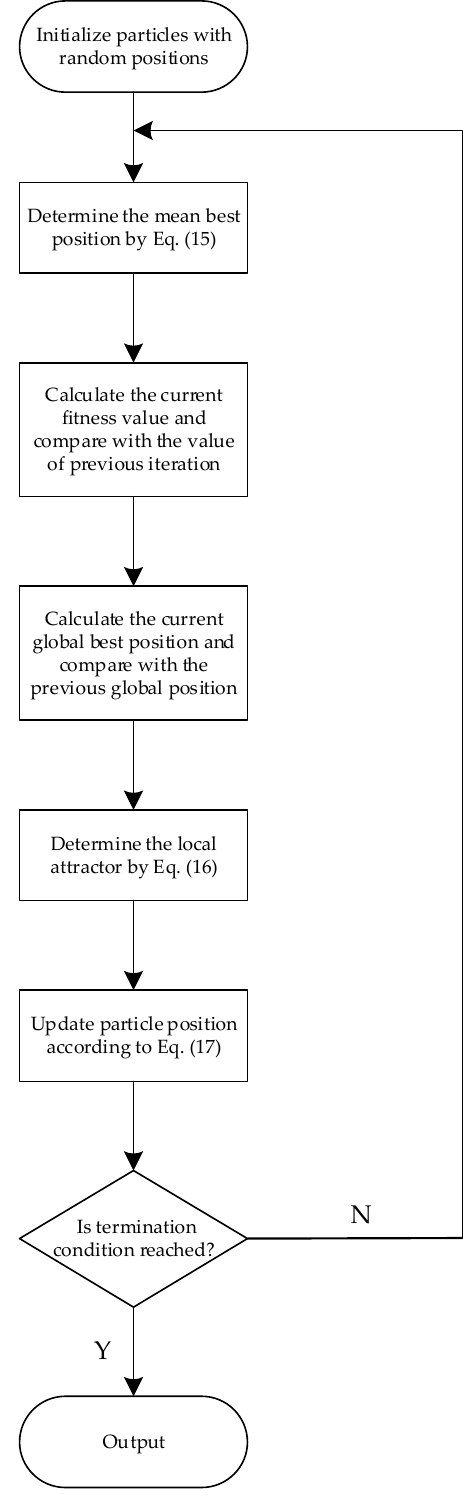
Figure 2. Diagram of Quantum-Behaved Particle Swarm Optimization (QPSO) algorithm.